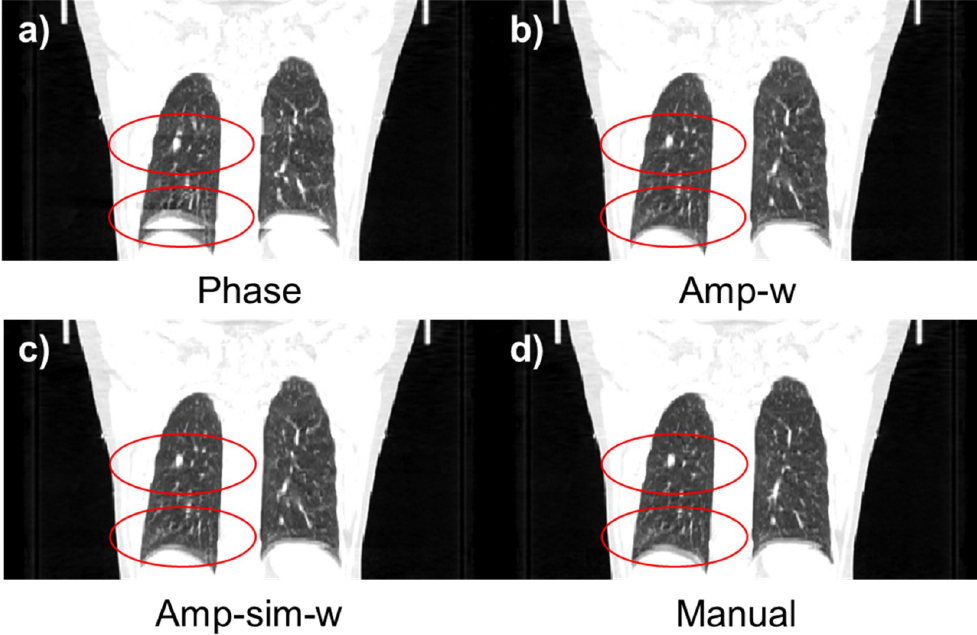
Fig 15. Coronal view of sorted 4DCT of the thoracic region according to the sorting algorithm. (Patient #19) (a) conventional phase sorting, b) amplitude-weighted phase sorting, c) amplitude-weighted phase sorting with image similarity, and d) manual sorting